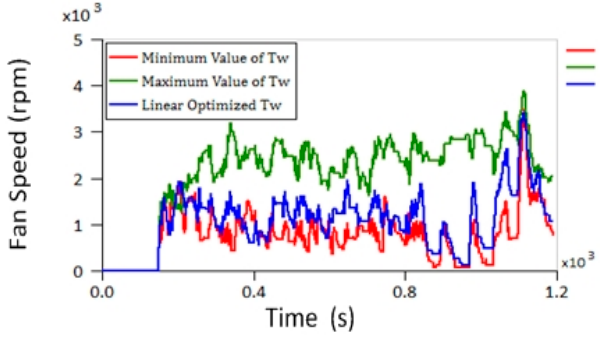
Figure 21. Comparison of the fan speed.